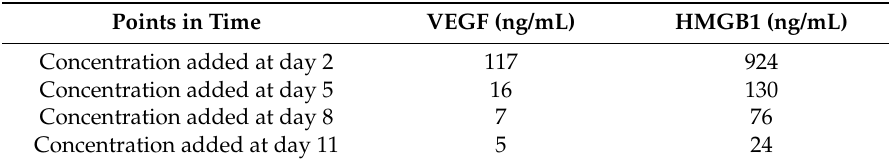
Table 4. Cytokine concentrations. Cytokine concentrations of VEGF and HMGB1 added to the angiogenesis assay at different points in time. Points in Time VEGF (ng/mL) HMGB1 (ng/mL) Concentration added at day 2 117 924 Concentration added at day 5 16